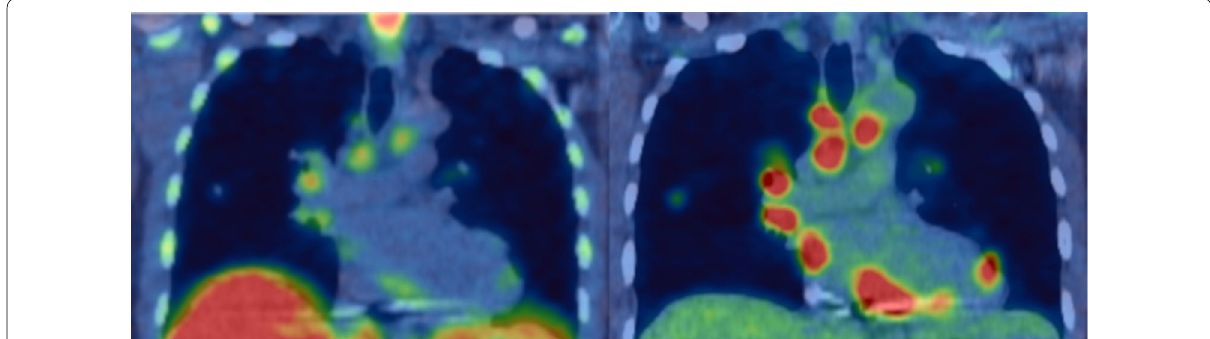
Fig. 5 Coronal section through the mediastinum demonstrating thoracic lymphadenopathy and cardiac involvement in a single subject on FLT‑PET (left) and FDG‑PET (right)